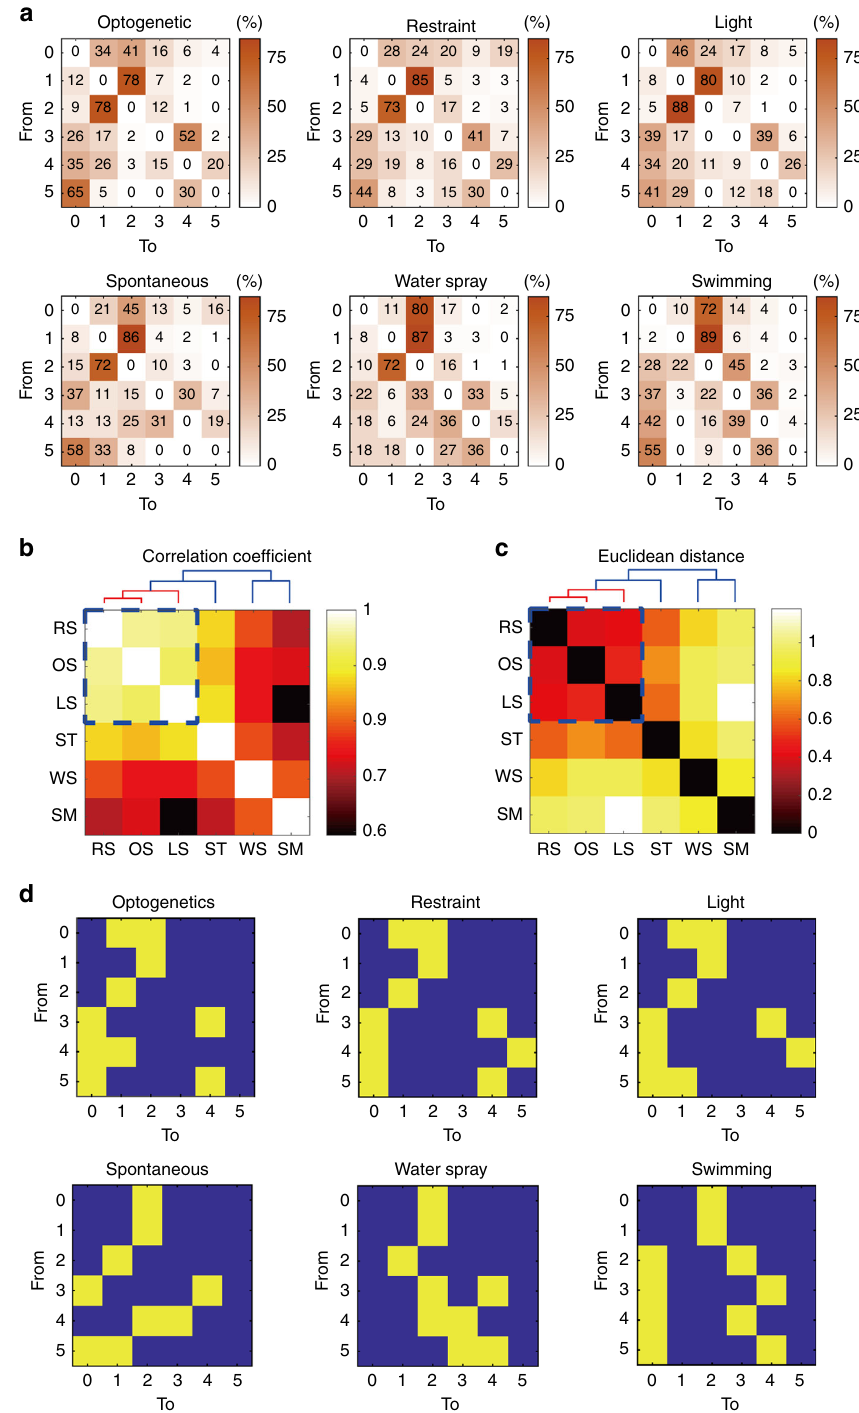
Fig. 7 Microstructure analysis of grooming under different contexts. a The transition probability matrices summarizing the likelihood from one grooming phase to another phase in the six grooming models. The different phases of no grooming/grooming activities were de fi ned as no grooming (phase 0), paw licking (phase 1), nose/face/head grooming (phase 2), body grooming (phase 3), leg grooming (phase 4) and tail/genital grooming (phase 5). The numbers show the occurrence in % and are colour-coded. b , c The correlation coef fi cients b , and Euclidean distances c between each pair of transition probability matrices were derived. Hierarchical clustering analysis supports a higher similarity of the optogenetics model and the restraint and light models. RS body restraint stress, OS optogenetics stimulation of LSv, LS bright light exposure, ST spontaneous grooming, WS water spray, SM swimming. d The patterns and microstructures of six grooming models summarized by the phase transition probability matrix shown in a were transformed into two-colour binary format using a threshold of 25% illustrating higher similarity among the optogenetics model, the restraint model and the light